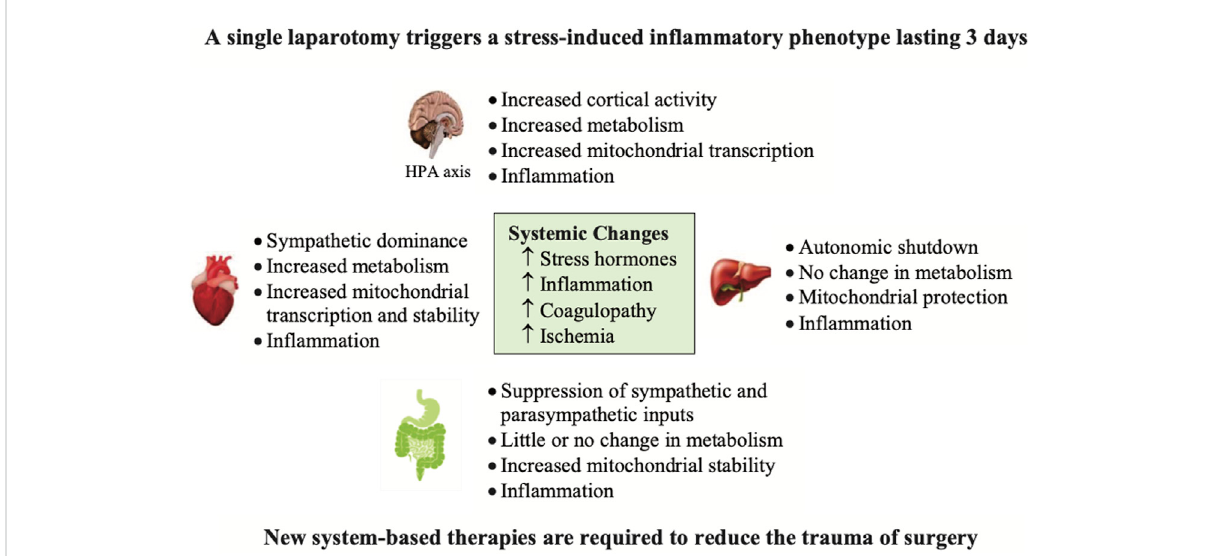
FIGURE 6 The effect of a single transverse laparotomy on receptor gene expression in a number of tissues of the rat over a 3 day period (Dobson et al., 2021a). The trauma of surgery led to a proin fl ammatory phenotype involving neuroendocrine stress, cortical excitability, immune activation, lymphocytopenia, hypermetabolism and coagulopathy (Dobson et al., 2021a). Of special note was the profound hyperactivity of the brain and heart withnomeasurablechangesinhemodynamics.Incontrast,theliverandgutunderwentdownregulationofadrenergicandmuscarinicreceptor expression. This study illustrates the widespread effect of a single incision mimicking an abdominal trauma on altering brain and whole body homeostasis with no further surgery or manipulation (Dobson, 2020a; Dobson et al., 2021a). HPA, hypothalamo-pituitary